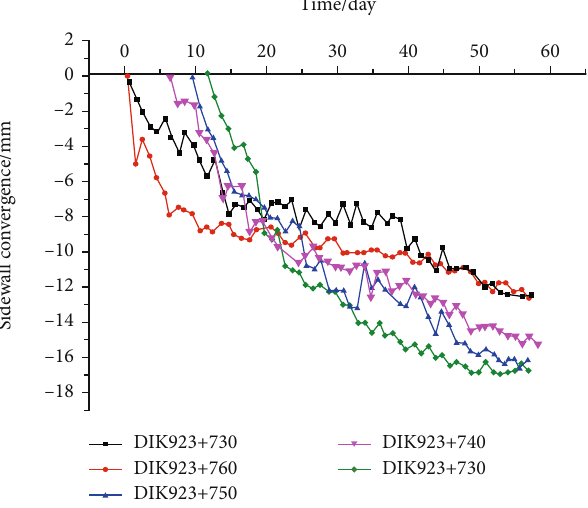
Figure 11: Convergence curve of side wall. Figure 12: Settlement curve of inverted arch.